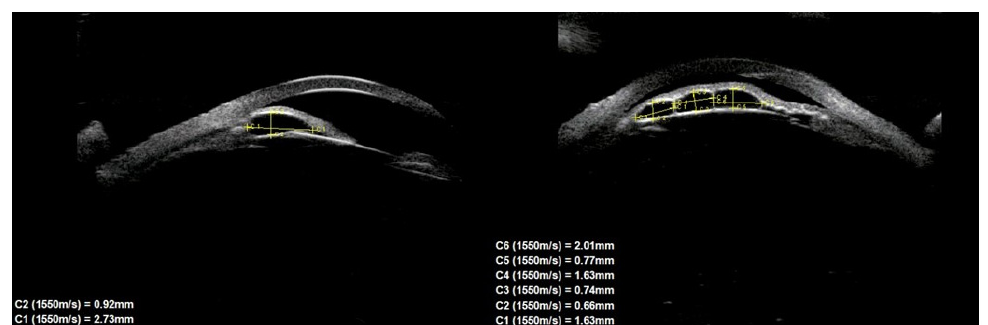
Figure 2. Multichamber cyst.